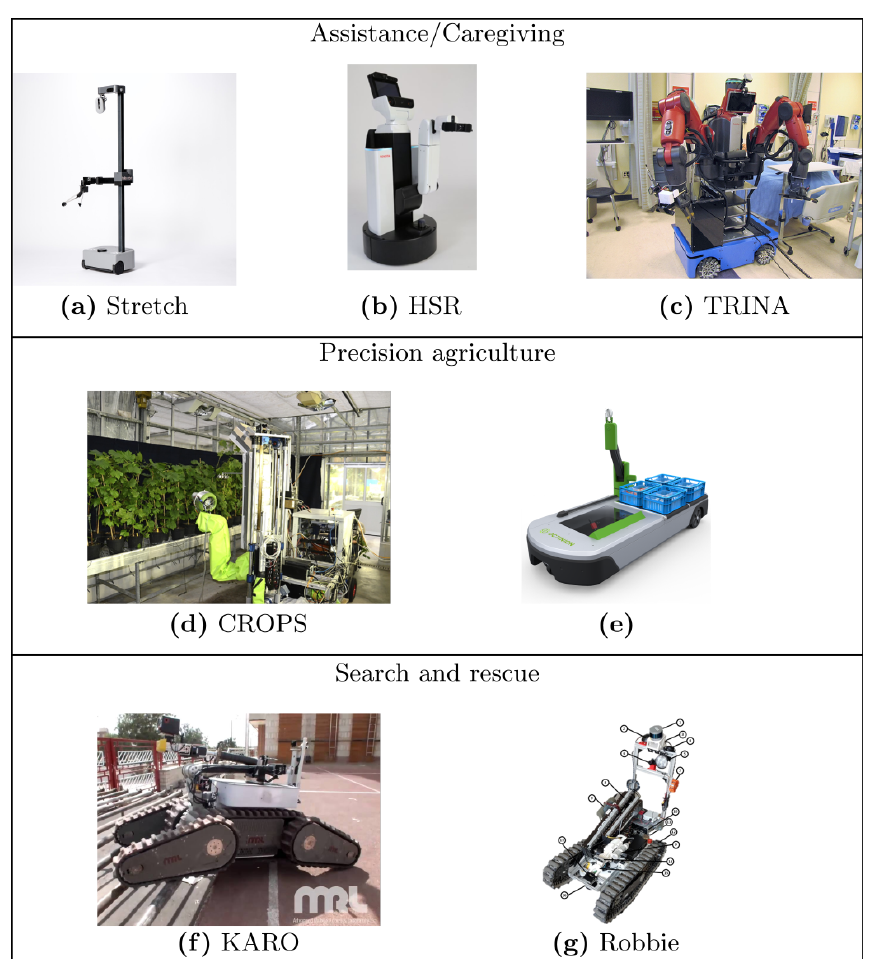
Figure 1. ( a ) Stretch, from hello robot company [5,6], ( b ) Human Support Robot (HSR), from Toyota company [7,8], ( c ) TRINA, developed by the researchers of Worcester Polytechnic Institute and Duke University [9,10], ( d ) CROPS, developed by the researchers of Università degli Studi di Milano, University of Ljubljana and Technische Universitat Munchen [11], ( e ) robot for strawberry harvesting, from Octinion [12,13], ( f ) KARO, developed by the researchers of the Advanced Mobile Robotics Lab, Qazvin Azad University [14], and ( g ) Robbie, developed by the researchers of Fachhochschule Technikum Wien